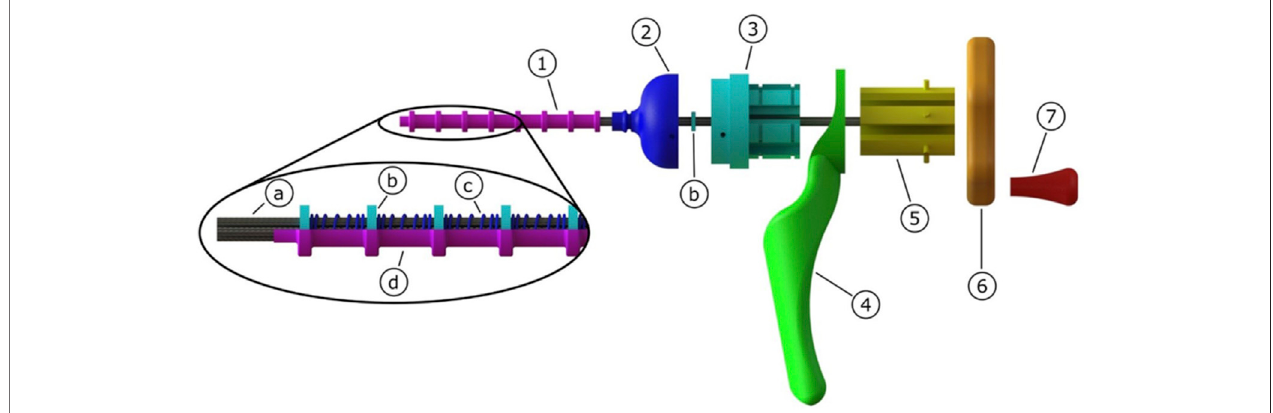
FIGURE 7 | Schematic representation of the fl exible transport mechanism consisting of 1) fl exible shaft, 2) tip, 3) slider house, 4) hand grip, 5) sliders, 6) cam, 7) crank. The fl exible shaft consists of a) cables that form a lumen due to their attraction to the b) ring magnets. The ring magnets are kept in place by c) compression springs, and all is enclosed by a d) heat shrink